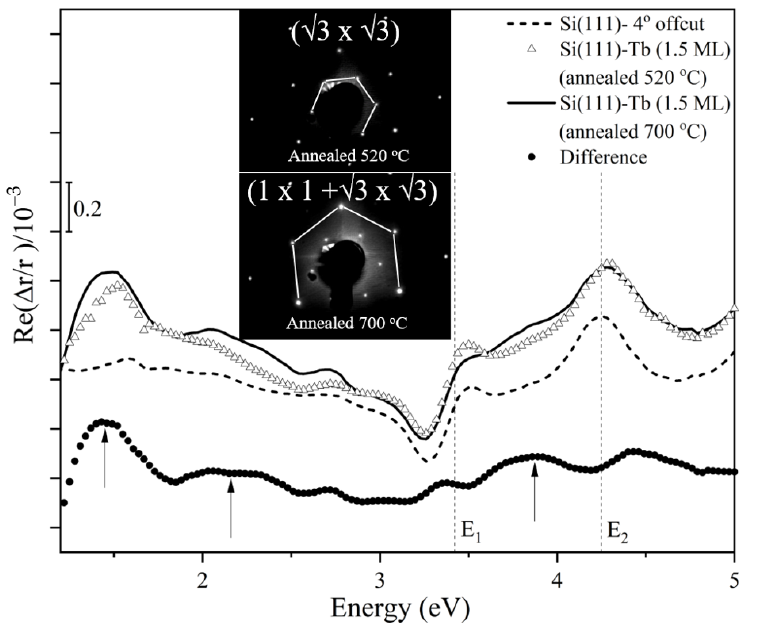
Figure 1. Reflectance anisotropy spectrum obtained before and after deposition of 1.5ML Tb on the 4 ◦ -offcut Si(111) substrate and annealing at different temperatures. The upper (lower) inset shows the corresponding LEED pattern after annealing at 520 ◦ C (700 ◦